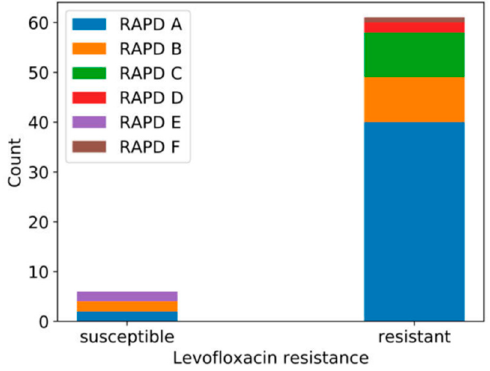
Figure 3. Stacked bar charts representing the number of strains with susceptibility or resistance to levofloxacin that have the different RAPD profiles.